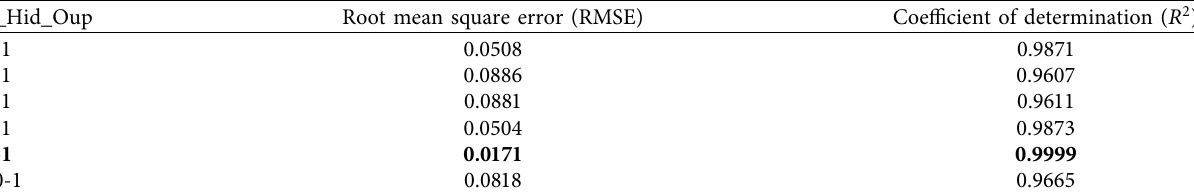
Table 7: Performance of ANN structure of Ra .